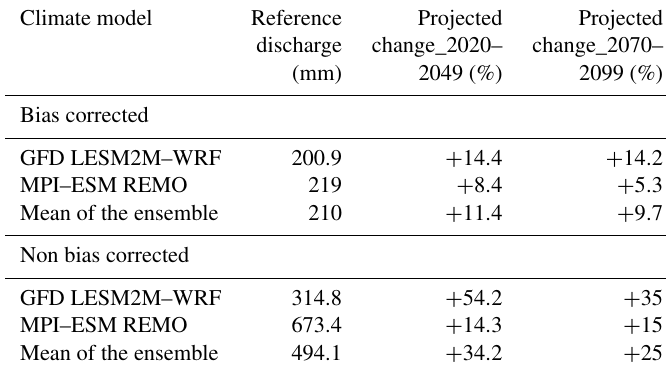
Table 3. Projected discharge change between the reference between the reference (1983–2005) and future periods reference (2020–2049) and future (2070–2099).